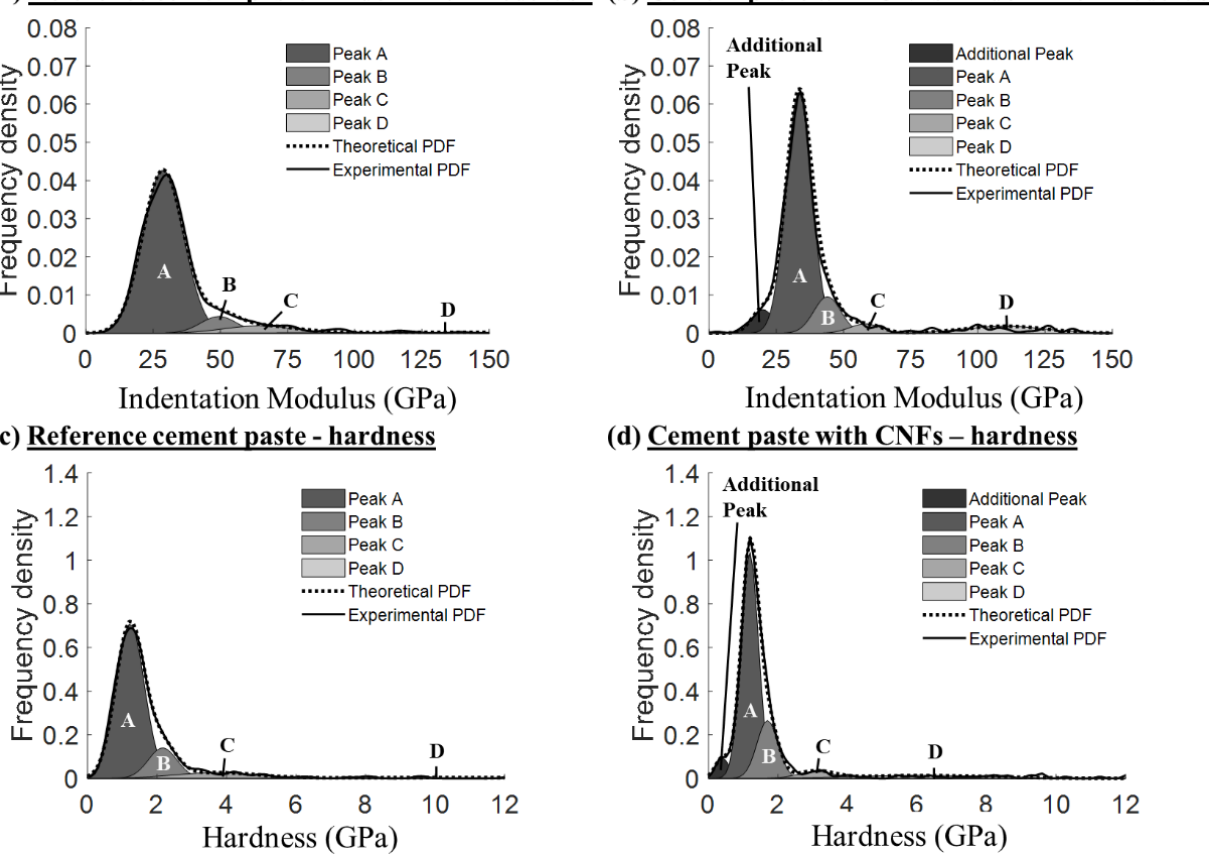
Figure 4. Multimodal Gaussian fitting results for the indentation modulus ( a , b ) and hardness ( c , d ) of the reference cement paste and cement paste with CNFs, respectively. * Indentation modulus data of the reference cement paste have been reported in [58] . Table 1. Mean values of the indentation modulus and hardness and percent of indents for each mechanically distinct peak identified for the reference cement paste and the cement paste with CNFs.